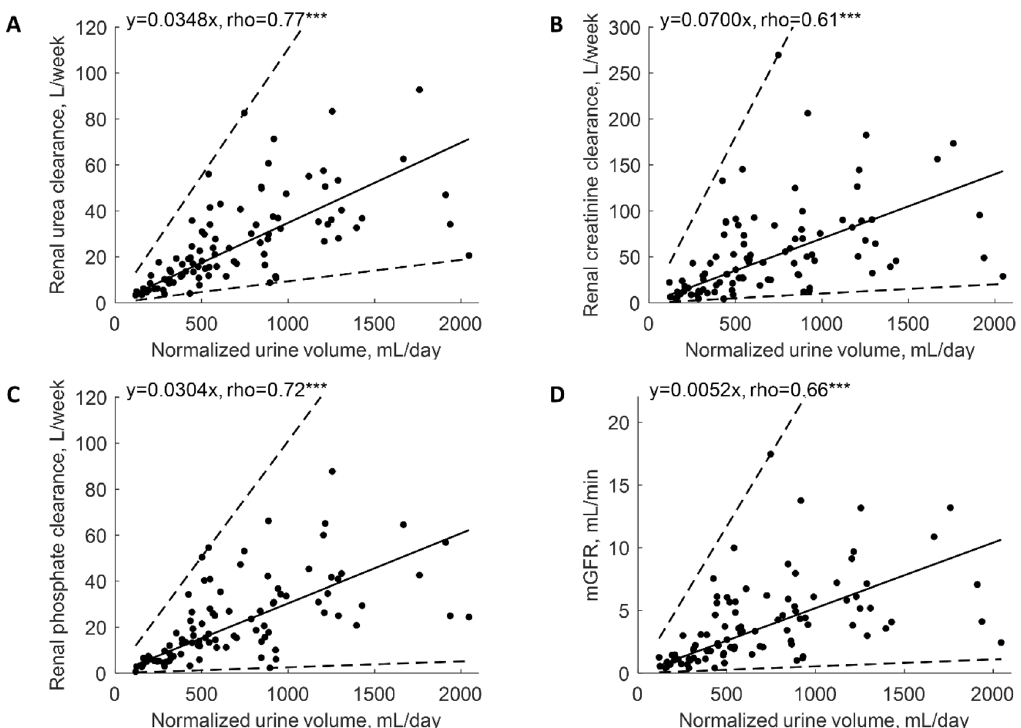
Figure 1. Residual renal urea clearance (panel A ), renal creatinine clearance (panel B ), renal phosphate clearance (panel C ) and measured glomerular filtration rate (mGFR, panel D ) as function of normalized urine volume. *** denote p value < 0.001. Solid line represents linear regression with equation displayed on the figure, dashed lines represent 0th and 100th percentile (minimum and maximum) of the data